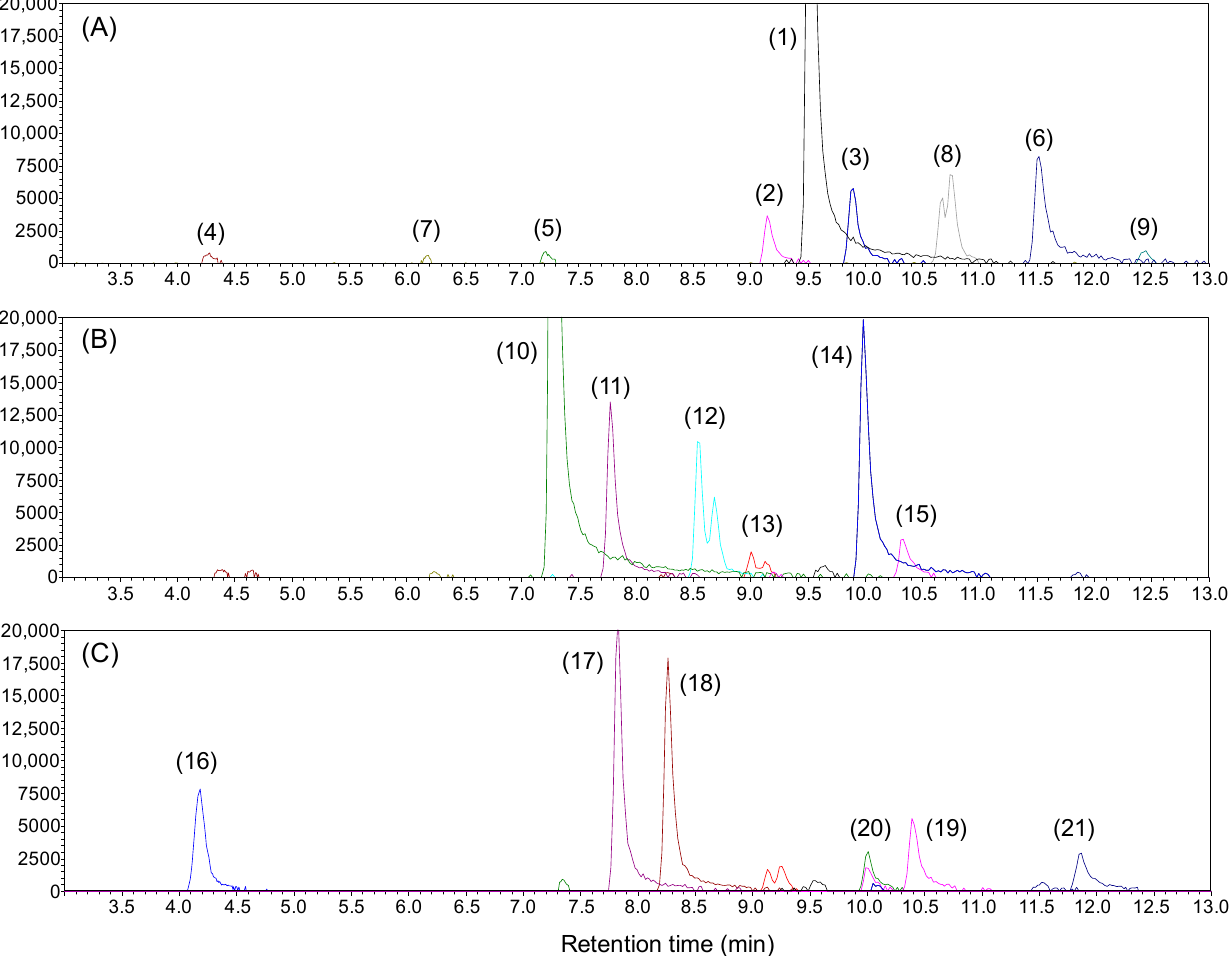
Figure 3. Extracted ion chromatograms of lipid A obtained from E. coli ( A ) wild type, and gene knockout strains of ( B ) lpxM and ( C ) lpxL . Elucidated structures and LC-MS data are summarized in Table 1.